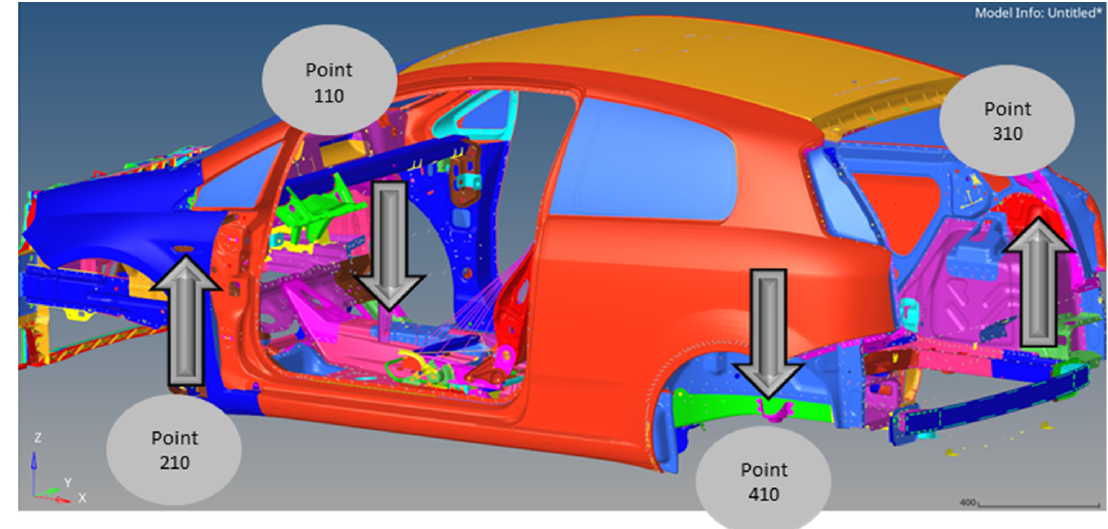
Figure 4. Moment applied on TB model to perform the forced response analysis. Analyzing the accelerations at the loaded points (Figure 5), and the modal shapes (Figure 6), the peak corresponding to the first global torsional mode became evident: the choice was on the second peak because the first one was related to a spurious torsional mode (by checking the animation of the modal shape, it is possible to point out that the maximum rotations at the posterior and at the anterior were not synchronized).